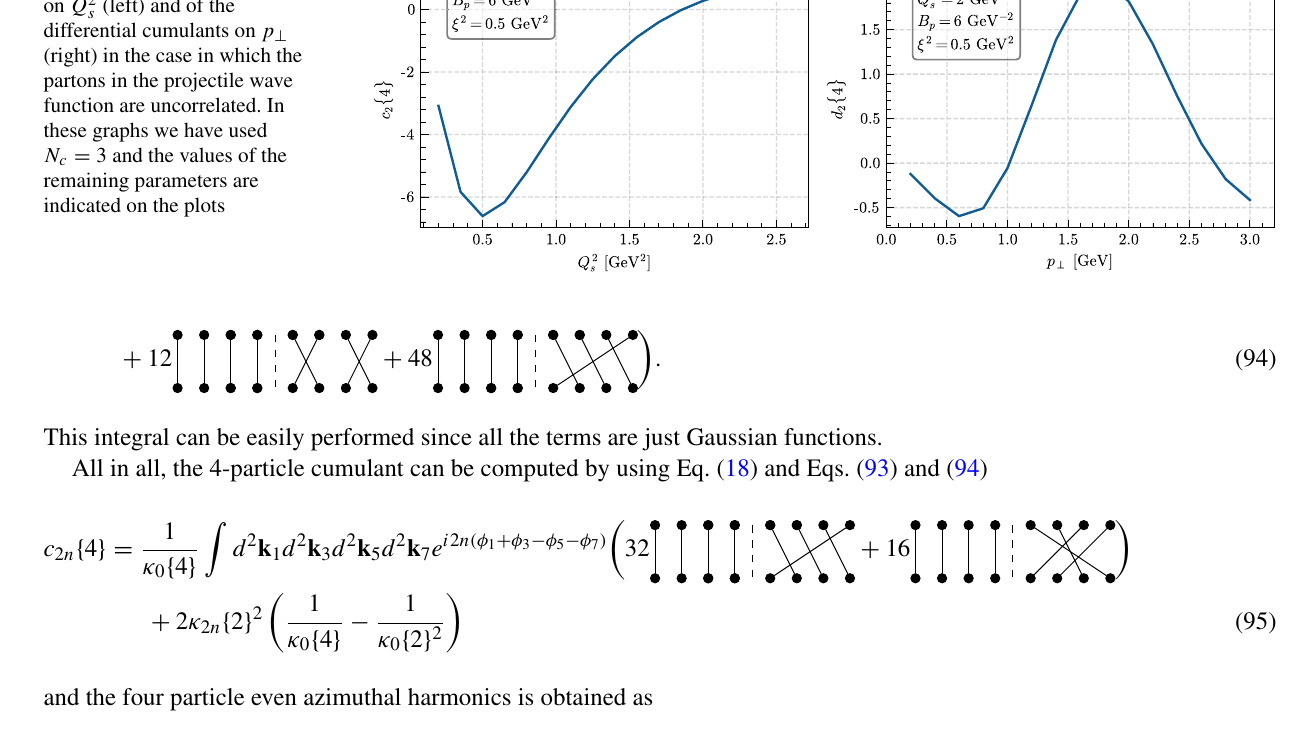
Fig. 6 Dependence of the 4-particle integrated cumulants on Q 2 s (left) and of the differential cumulants on p ⊥ (right) in the case in which the partons in the projectile wave function are uncorrelated. In these graphs we have used N c = 3 and the values of the remaining parameters are indicated on the